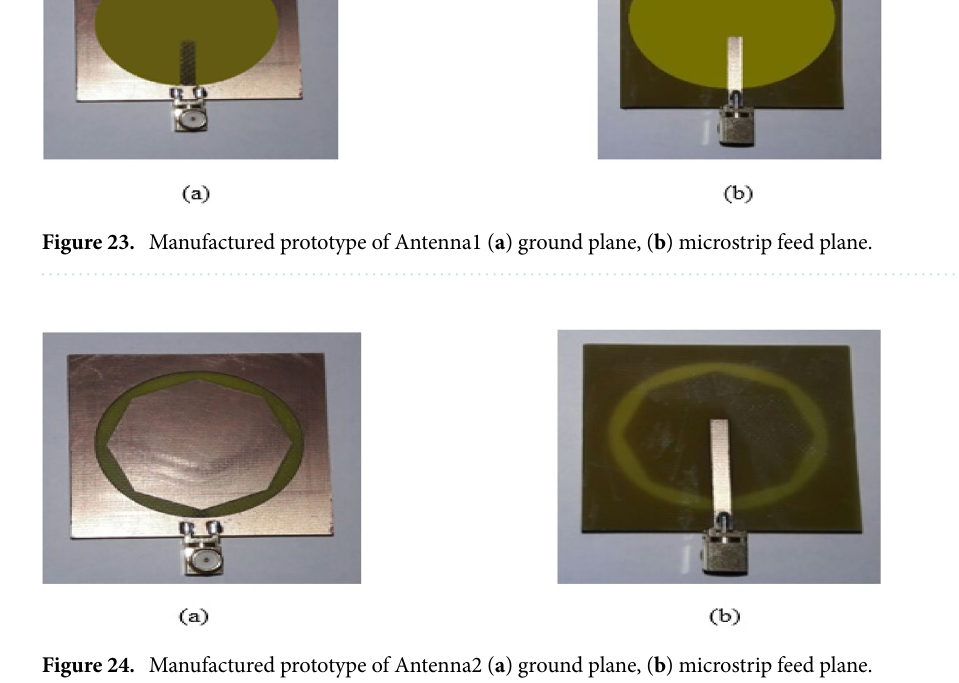
Figure 24. Manufactured prototype of Antenna2 ( a ) ground plane, ( b ) microstrip feed plane.